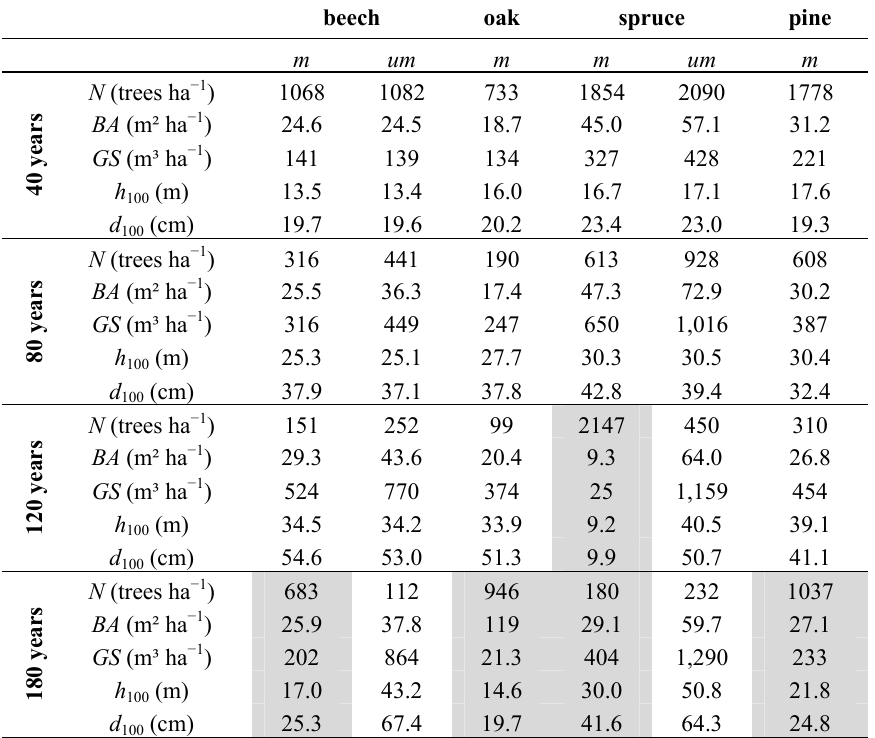
Table 1. Stand characteristics of the modeled stands at selected points of the 180-year simulation period, where BA is the basal area, GS the growing stock (standing gross volume over bark), h the top height (mean height of the 100 biggest trees), d 100 of the 100 biggest trees, m the managed and um the unmanaged stands. At 180 years, the subsequent beech stand is 55, the oak stand 40, the spruce stand 75 and the pine stand 50 years old. The grey area indicates a new rotation.